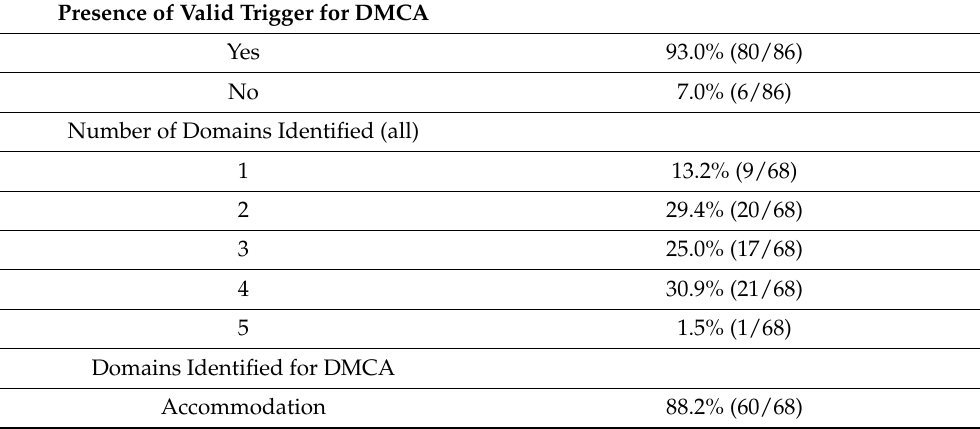
Table 2. Characteristics of DMCA Process,